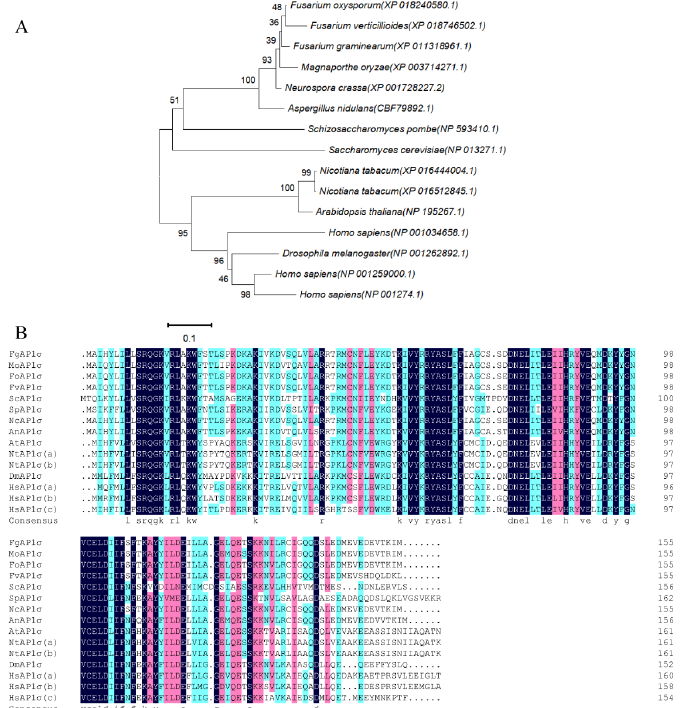
Figure 1. Bioinformatics analyses of FgAP1 σ homologues. ( A ) Phylogenetic relationship of FgAP1 σ protein from different organisms. The gene names are from the Broad Institute genome annotation: Fusarium graminearum (XP_011318961.1), Magnaporthe oryzae (XP_003714271.1), Fusarium ox- ysporum (XP_018240580.1), Fusarium verticillioides (XP_018746502.1), Saccharomyces cerevisiae (NP_013271.1), Schizosaccharomyces pombe (NP_593410.1), Neurospora crassa (XP_001728227.2), Aspergillus nidulans (CBF79892.1), Arabidopsis thaliana (NP_195267.1), Nicotiana tabacum (XP_016444004.1), Nicotiana tabacum (XP_016512845.1), Homo sapiens (NP_001259000.1), Homo sapiens (NP_001274.1), Homo sapiens (NP_001034658.1), Drosophila melanogaster (NP_001262892.1). ( B ) Multiple alignment of amino acid sequences of FgAP1 σ homologues.